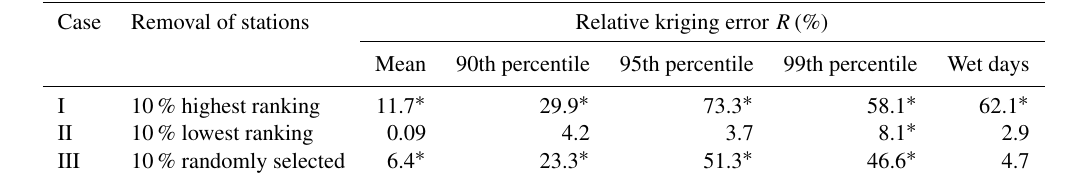
Table 1. Relative kriging error for the three different cases. The relative kriging error for case III is the average across 10 trials. An asterisk indicates a high relative error greater than 5%.